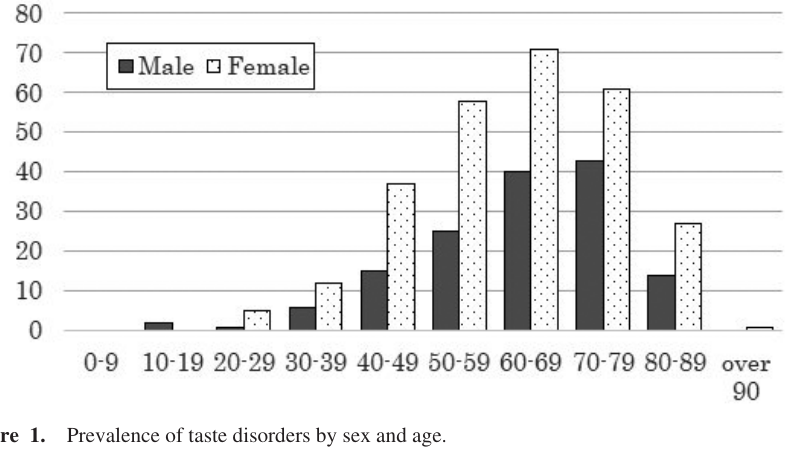
Figure 1. Prevalence of taste disorders by sex and age. The 419 patients consisted of 146 (34.8%) males and 273 (65.2%) females. The age range was 16 to 90 years. 81.4% of the patients were > 50 years, whereas only two patients were < 20 years.